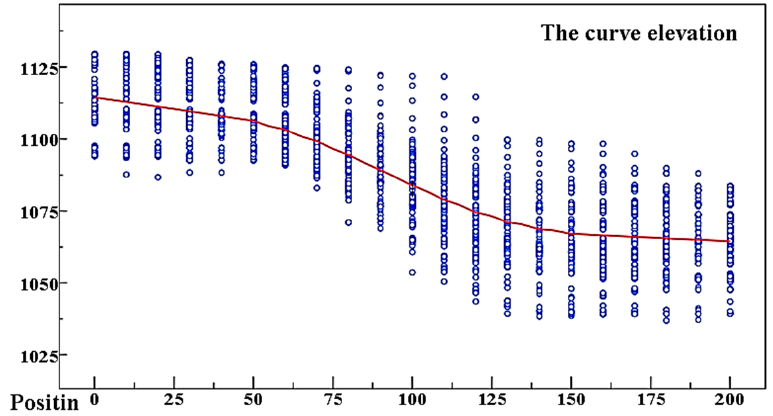
Figure 13. Fitting the cast blasting stockpile profile of the 35 m step height.